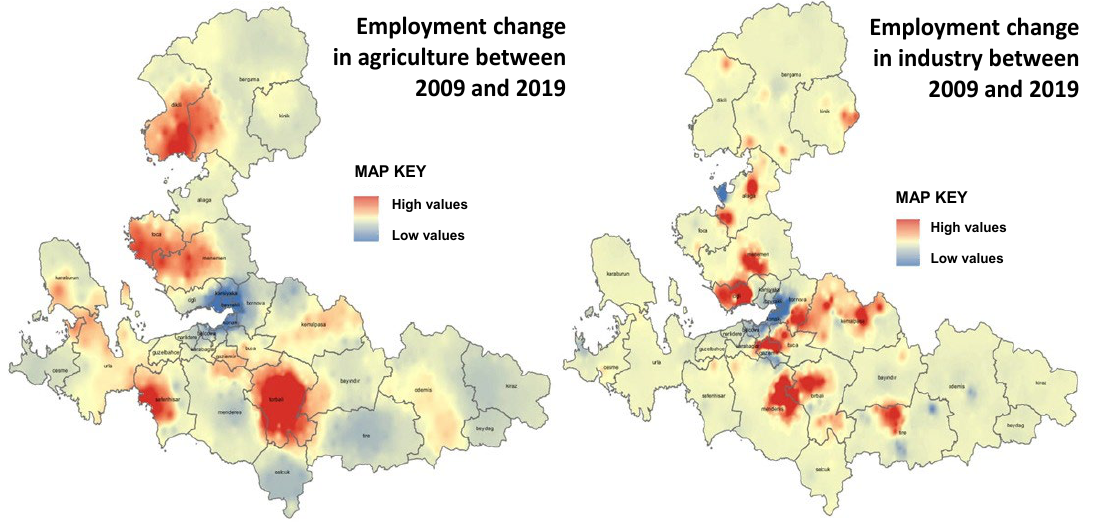
Figure 8 Agglomeration of employment change in the industry sector between 2009 and